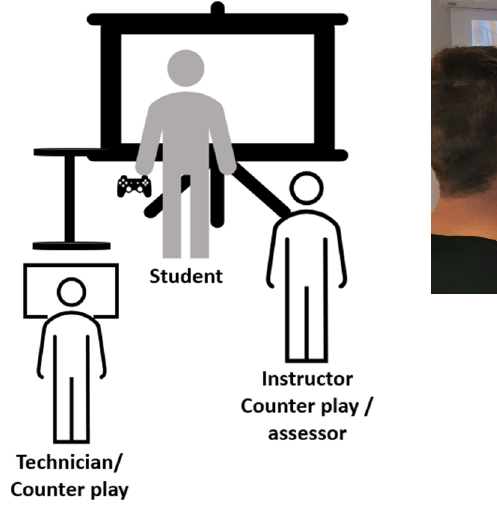
Table 1. Students’ response ( n = 90) to VS training on-site, excerpt from [66]. Answers in Likert scale, 1 (low) to 5 (very